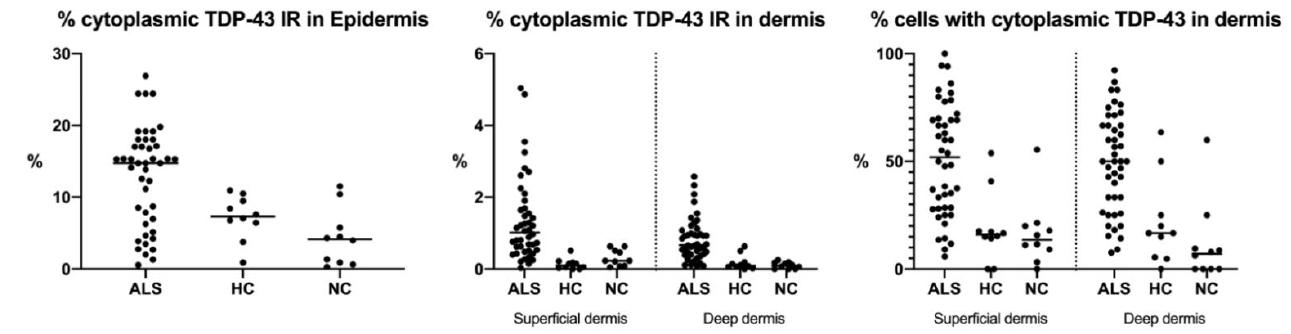
Figure 2. Distribution of the amount of cytoplasmic TDP-43 content and cells with cytoplasmic TDP-43 of the three cohorts in the different skin layers. IR: immunoreactivity; ALS: amyotrophic lateral sclerosis; HC: healthy controls; NC: neurological controls.